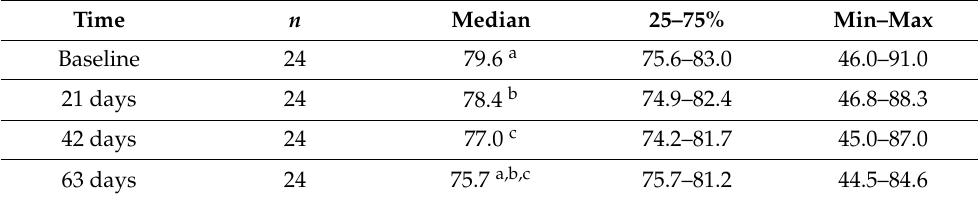
Table 1. Leopard gecko body weights (grams) over time.